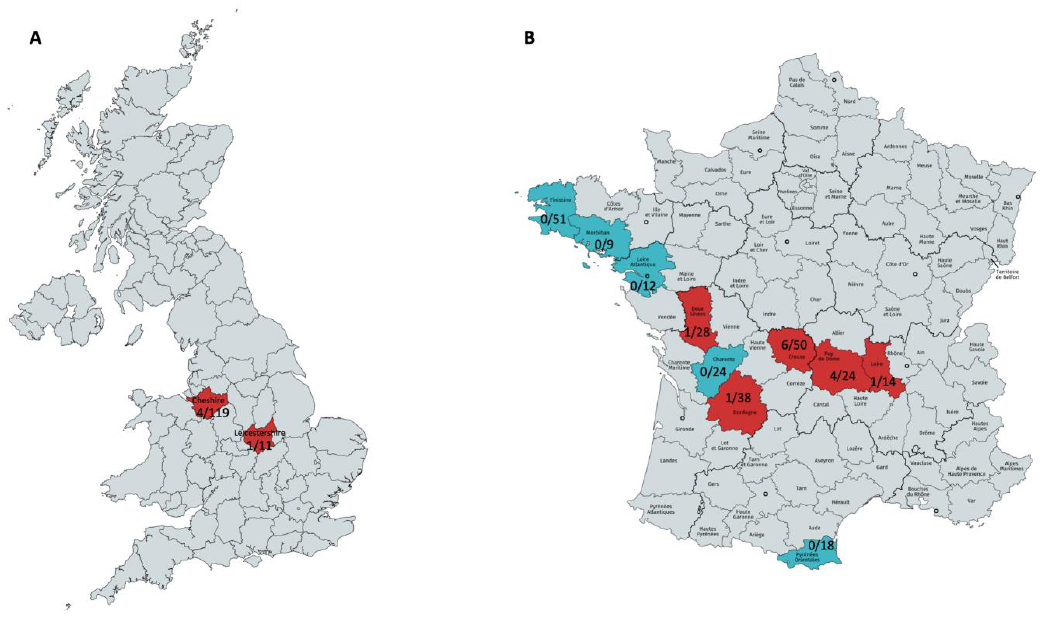
Figure 1. Maps of the UK ( A ) and France ( B ) illustrating the regions that the field vole paramyxovirus ( A ) and rabbit rotavirus A ( B ) were detected, along with their frequency. ( A ) Cheshire and Leicestershire (highlighted in red) had four and one positive field voles with paramyxovirus. ( B ) The departments Creuse, Puy-de-Dôme, Deux-Sèvres, Loire and Dordogne (highlighted in red) had six, four, one, one and one positives, respectively. The departments Charente, Finistère, Morbihan, Loire Atlantique and Pyrénées Orientales had no positives.